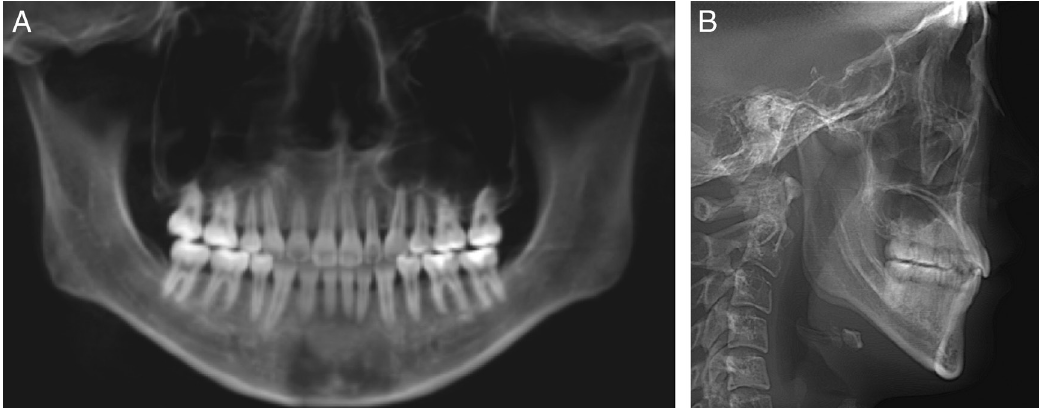
Figure 11. Post-treatment panoramic radiograph (A) and lateral cephalometric radiograph